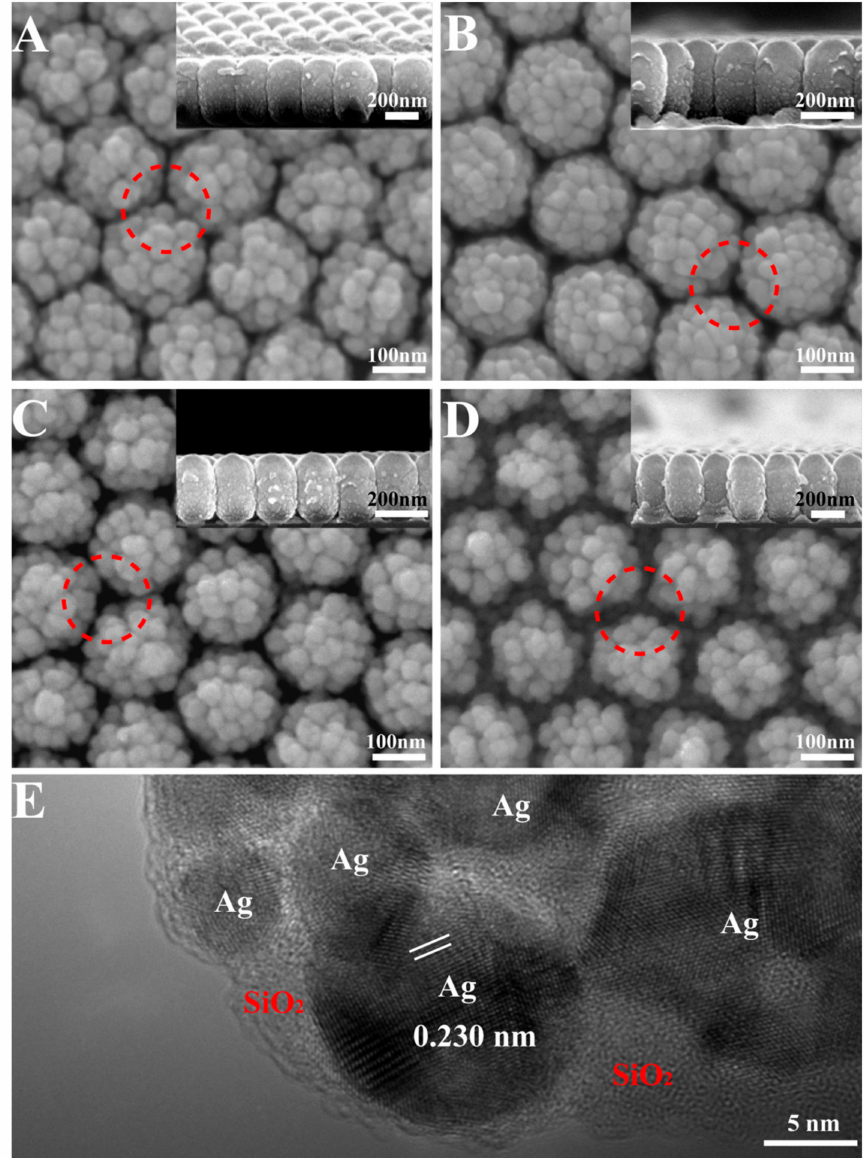
Figure 2. Top-view SEM ( A – D ) images of the Ag–SiO 2 nanomace arrays with etching for ( A ) 0 s; ( B ) 60 s; ( C ) 90 s; ( D ) 120 s. HRTEM image ( E ) of the Ag–SiO 2 nanomace arrays. The illustrations are of cross-sections of the